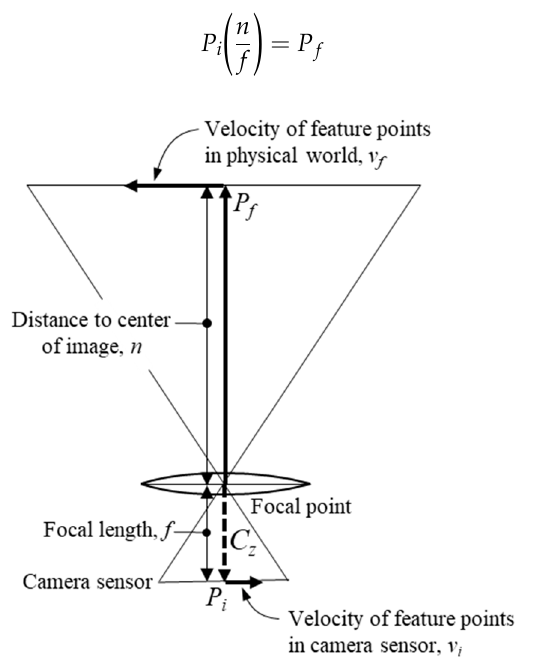
Figure 4. Pinhole model of a camera used for optical flow derivation.